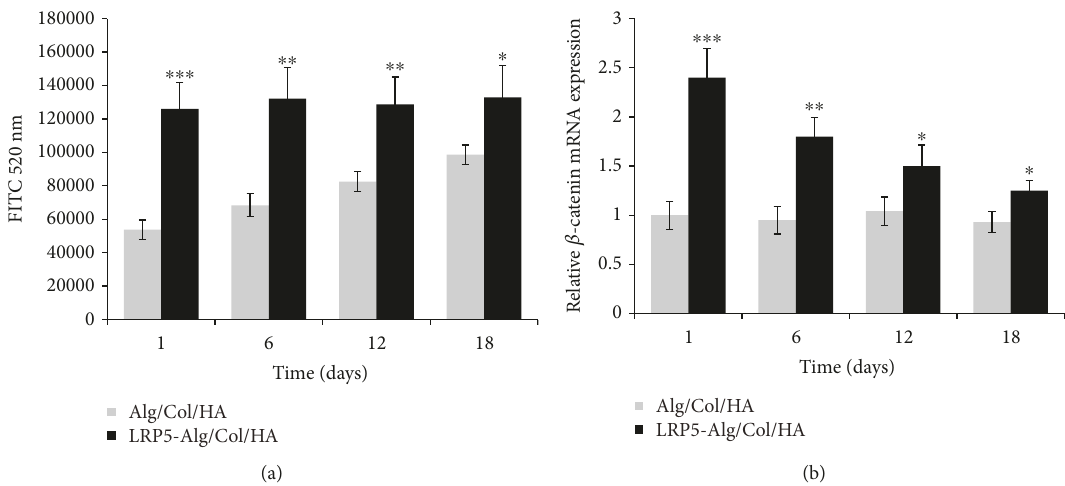
Figure 5: E ff ect of released LRP5 from LRP5-Alg/Col/HA to DKK1 binding and bioactivity in Wnt signaling pathway. (a) At di ff erent release times, the DKK1 binding activity of LRP5 released from LRP5-Alg/Col/HA. (b) At di ff erent release times, the e ff ect of LRP5 released from LRP5-Alg/Col/HA on mRNA expression of β -catenin in rat BMCs. ∗ P < 0 05 , ∗∗ P < 0 01 and ∗∗∗ P < 0 001 indicates the comparison with the Alg/Col/HA.